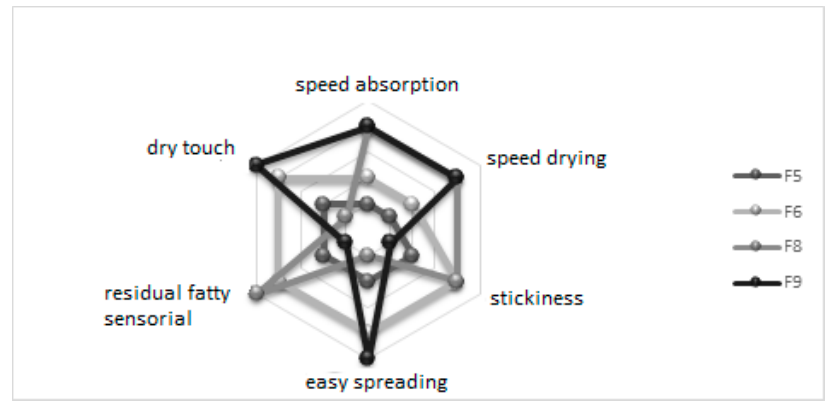
Figure 1. Evaluation of aspects such as speed absorption, residual fatty sensorial, speed drying, stickiness, spreading, and dry touch of base formulations (F5, F6, F8, and F9) by sensorial analysis.